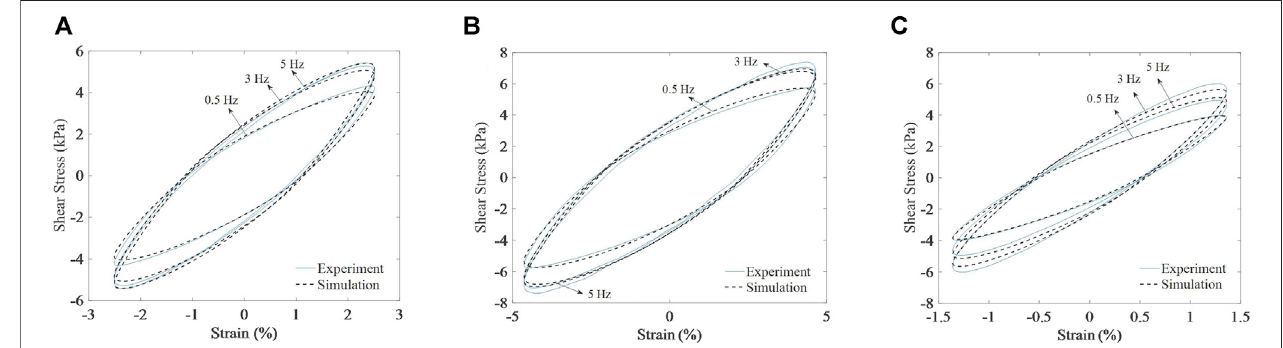
FIGURE 13 | Simulation data and experimental data under non identi fi cation condition: (A) 115 mT-2.51%; (B) 115 mT-4.64%; and (C) 234 mT-1.36%.